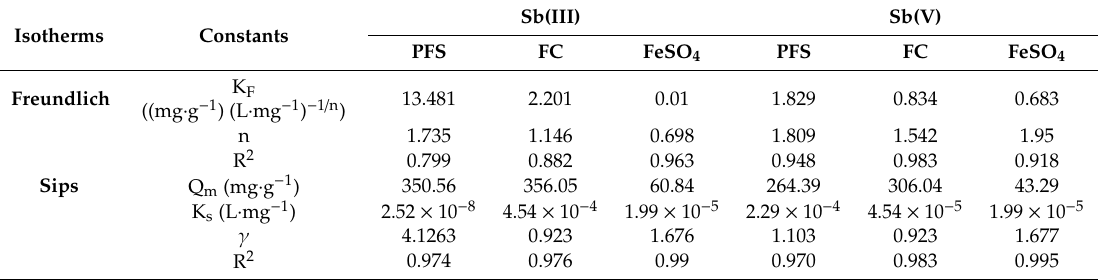
Table 1. Constants of Freundlich and Sips isotherms for Sb(III) and Sb(V) adsorption on hydrous ferric oxide flocs.